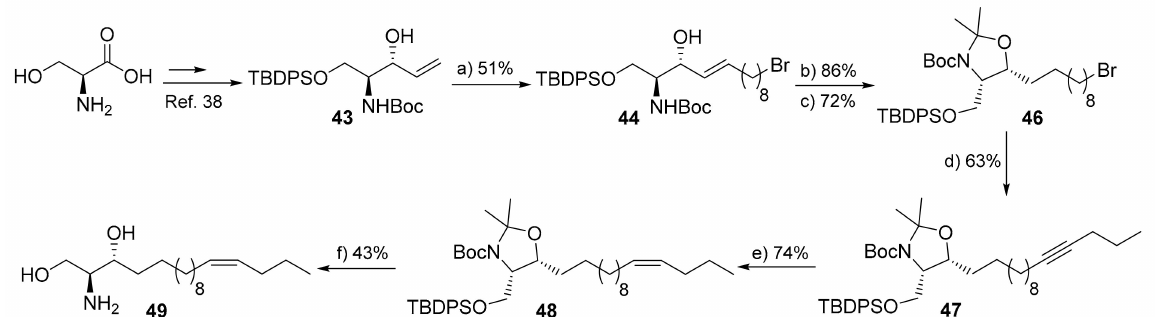
Scheme 7. Synthesis of 14 Z -sphingosine ( 49 ). Reagents and conditions: ( a ) 10-bromo-1-decene, p -benzoquinone (10